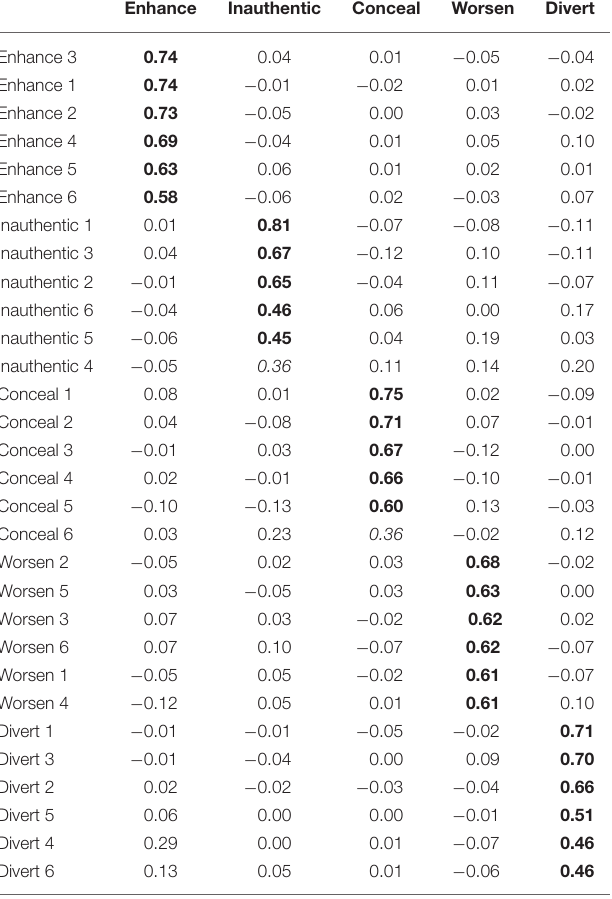
TABLE 2 | Exploratory factor analysis of the MEOS-SF.